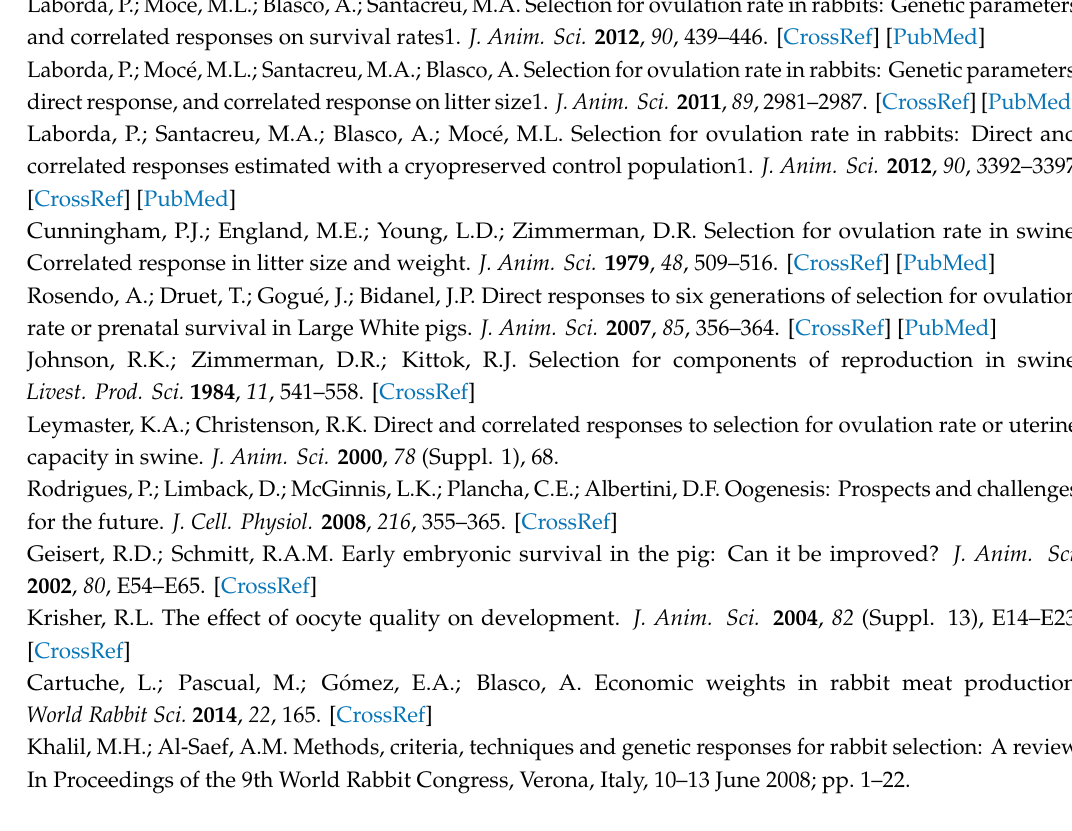
Table S1: 1357 di ff erentially expressed genes between females from the line selected for ovulation rate during 10 generations (OR line) vs. the control line (C